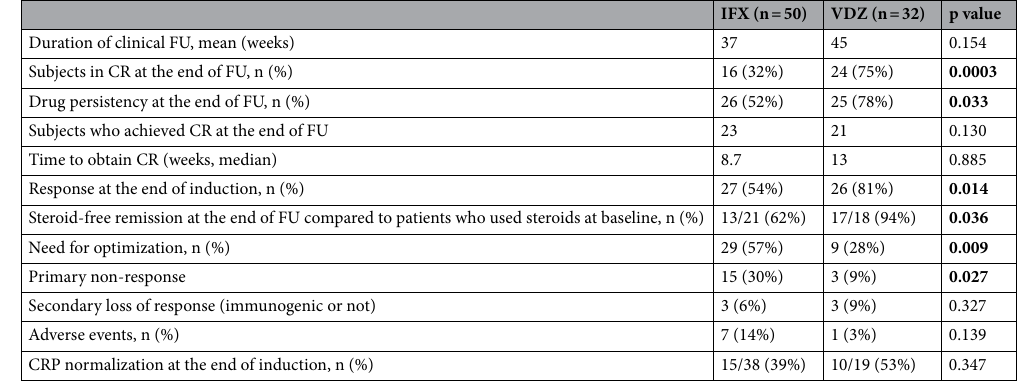
Table 3. Main results obtained comparing Infliximab (IFX) and Vedolizumab (VDZ) in naïve patients with Ulcerative Colitis. p value was obtained by chi-square, exact Fisher, odds ratio, log-rank test, and t Student’s test. FU follow-up, CRP C-reactive protein. Significant values are in bold.